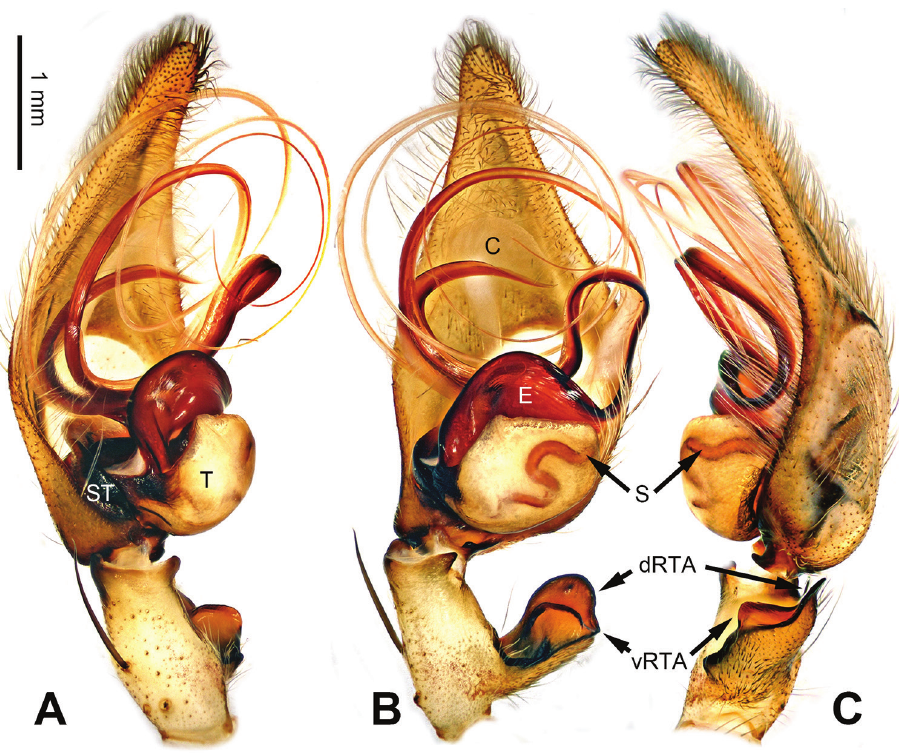
Figure 12. Pseudopoda maeklongensis Zhao & Li, sp. n., right palp of male holotype, horizontally flipped for the sake of comparison. A Prolateral view B Ventral view C Retrolateral view. Scale bar equal for A, B, C